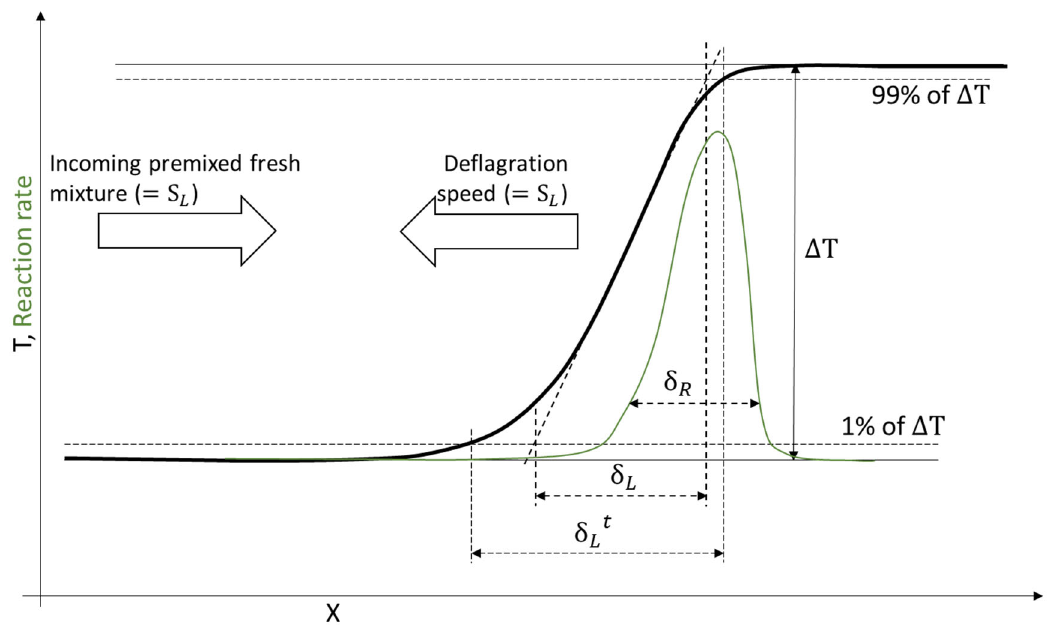
Figure 1. Generic stationary laminar flame front, including different definitions of flame thickness. Here, “reaction rate” is defined as the sum of the absolute values of the time derivatives of all of the present species’ molar fractions ( ∑ (cid:4698) (cid:3031)(cid:3025) (cid:3294)